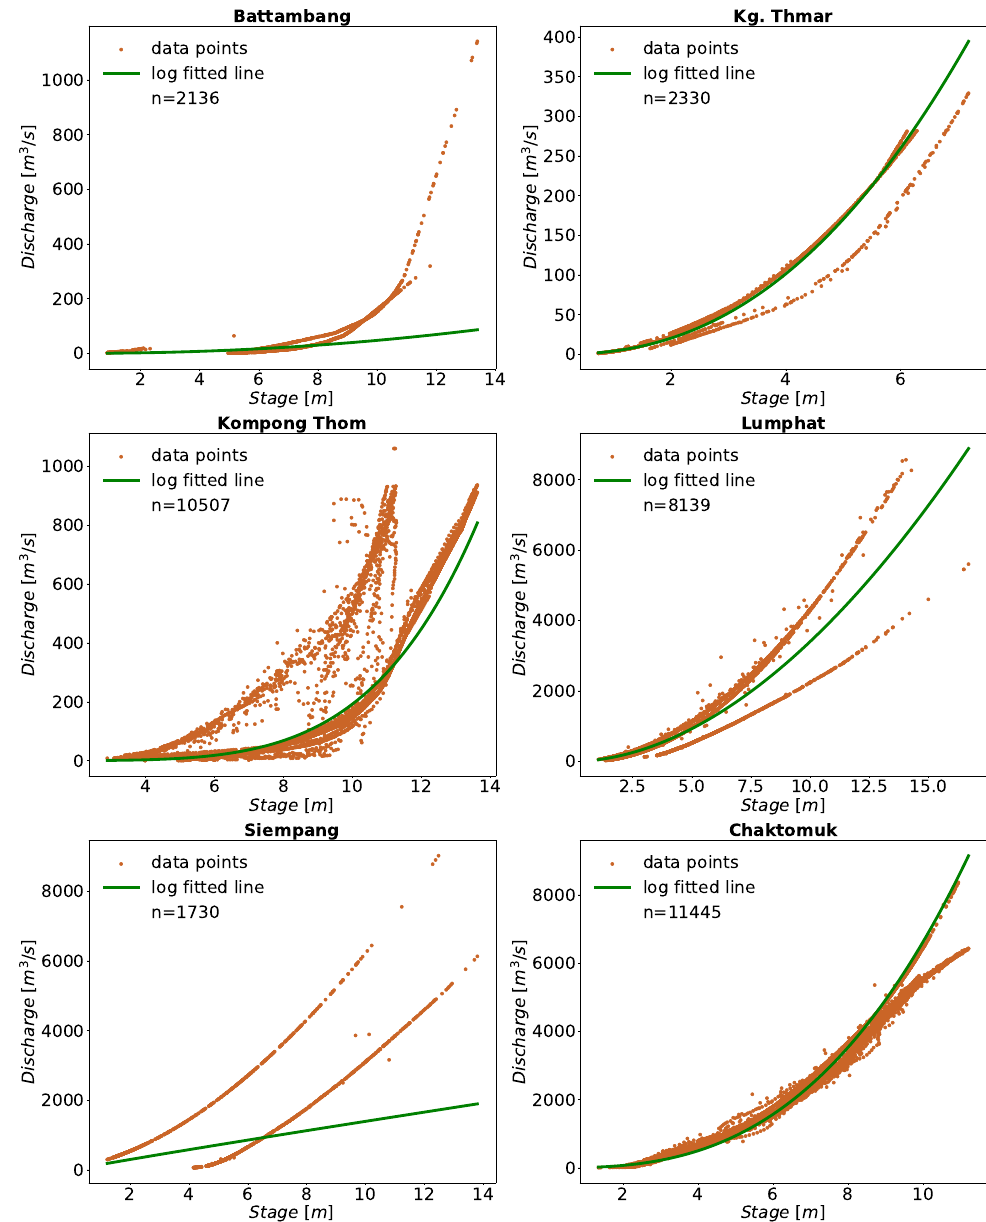
Figure 3. The plot of stage-discharge in Cambodia depicted more than one Rating Curve. The figure also shows a power fitted line to the data points. In addition, the stations contained outlier records in the